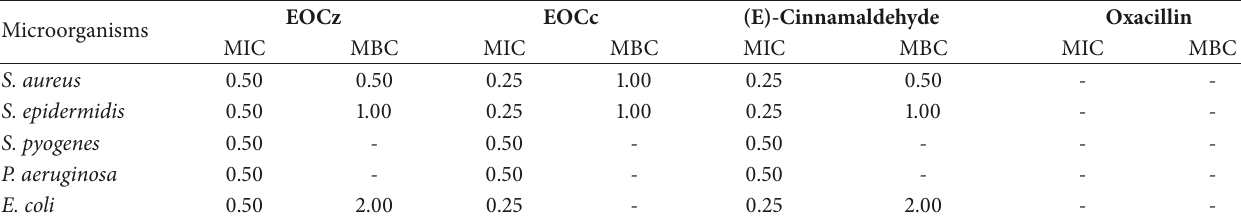
Table 2: Minimum inhibitory concentration (MIC) and minimum bactericidal concentration (MBC) values of essential oils from C. zeylanicum and C. cassia stems, (E)-cinnamaldehyde and oxacillin (mg/ml) on bacteria. Microorganisms